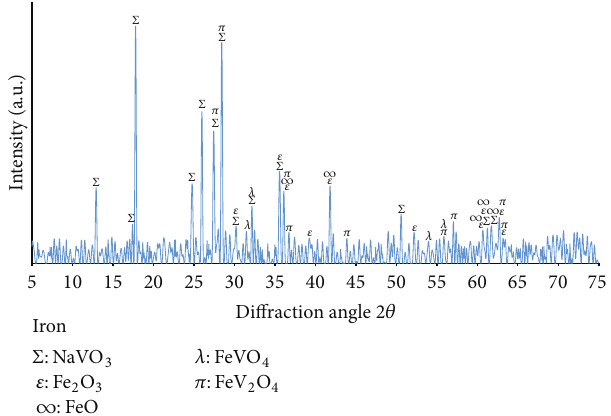
Figure 7: X-ray diffraction results of corrosion products of iron exposed to NaVO 3 at 700 ∘ C during 100 hours.